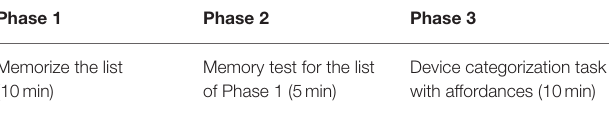
TABLE 2 | Procedures of Experiment 1.